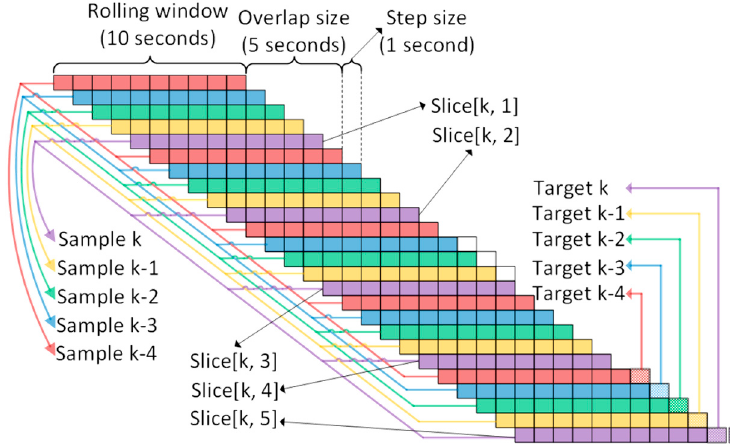
Figure 2. The schematic representation of windowing of different physiological variables.